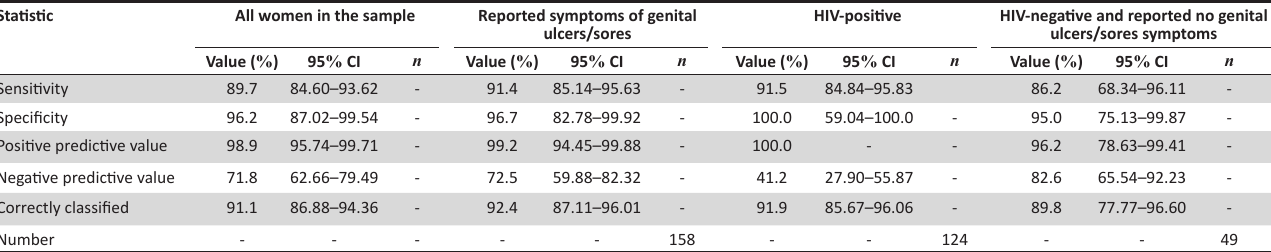
HIV-positive and reported no symptoms of genital ulcers or sores ( n = 85) ELISA, enzyme-linked immunosorbent assay.